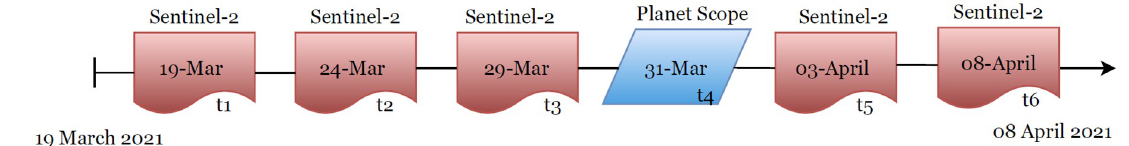
Fig 4. Five Sentinel-2 and one Planet-Scope scenes acquired over the area of interest, Harichand Charsadda. The imageries have been stacked in temporal arrangement for LSTM.